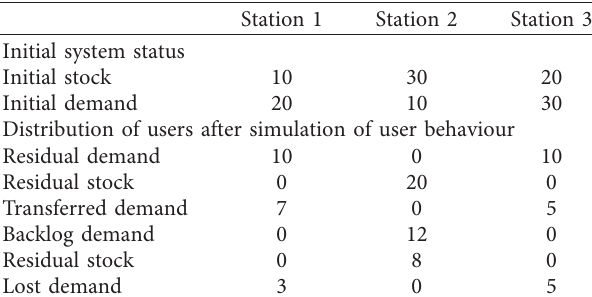
Figure 1: Acceptance and neighbouring zones of a station i Table 2: Illustration of user behaviour for a three-station system.